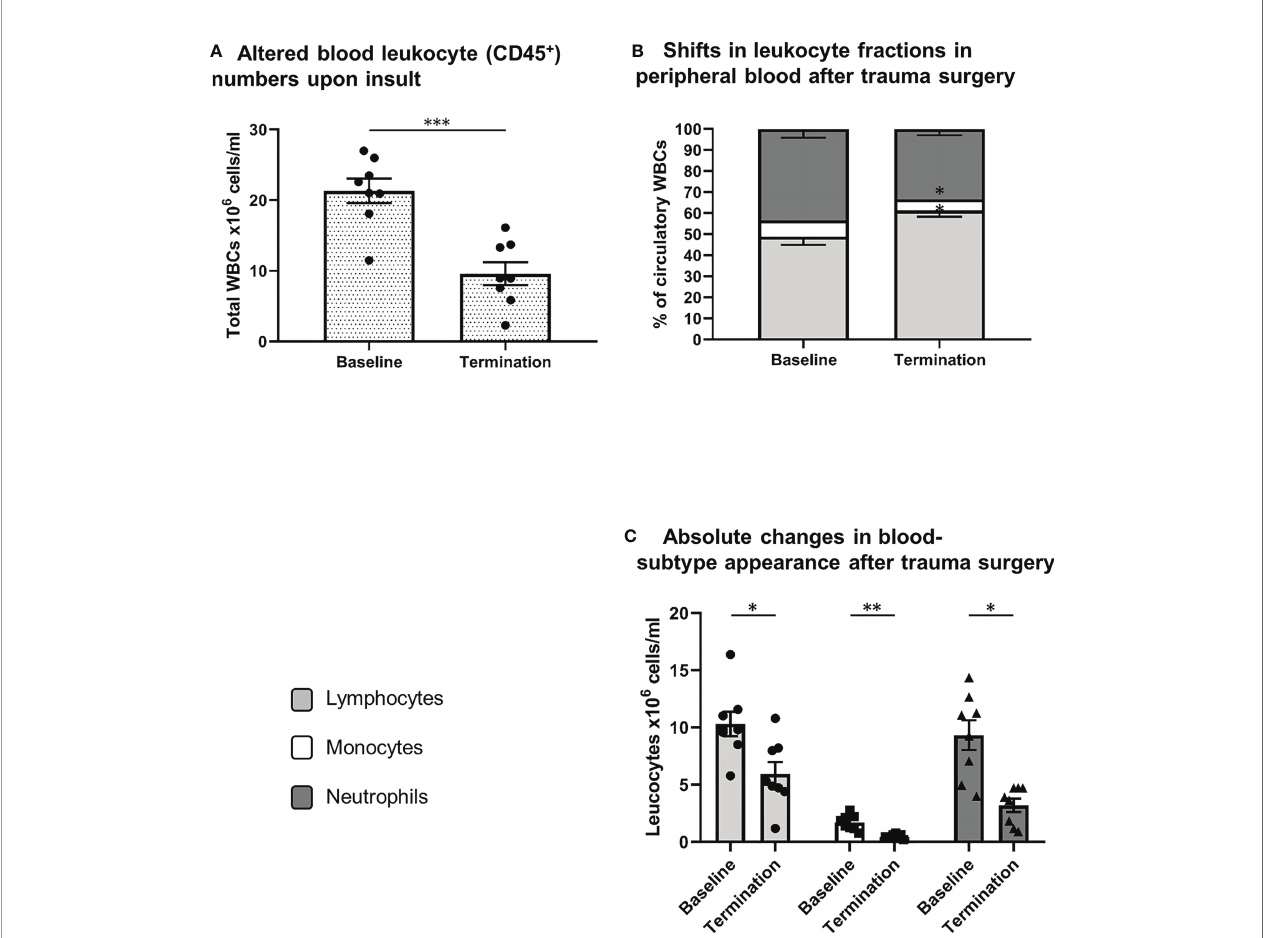
FIGURE 3 | Systemic leukocyte alterations after trauma surgery. (A) Difference in white blood cell count between both conditions (baseline vs. termination). Relative (B) and absolute (C) differences in lymphocyte, monocyte and neutrophil numbers between baseline and termination, re fl ecting shifts in leukocyte fractions after trauma surgery. S/FSC, sideward/forward scatter signal; N, neutrophils; M, monocytes; L, lymphocytes *P < 0.05, **P < 0.01, ***P < 0.001. Baseline samples were taken prior to intervention and termination sampling was performed directly after the fi nal